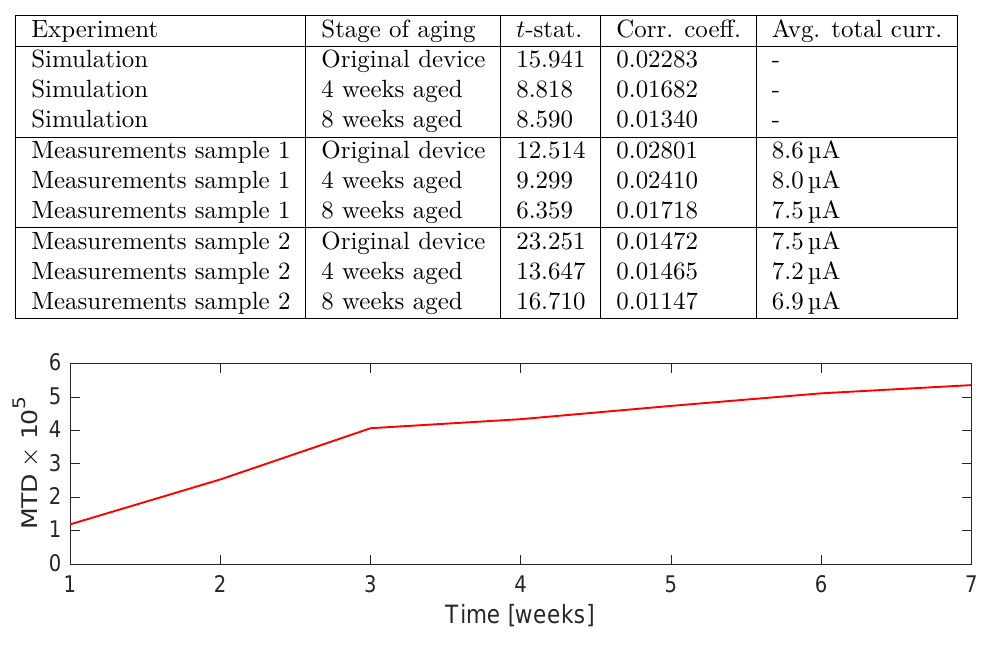
Table 1: Comparison of the simulation and practical measurements on both 65 nm samples.